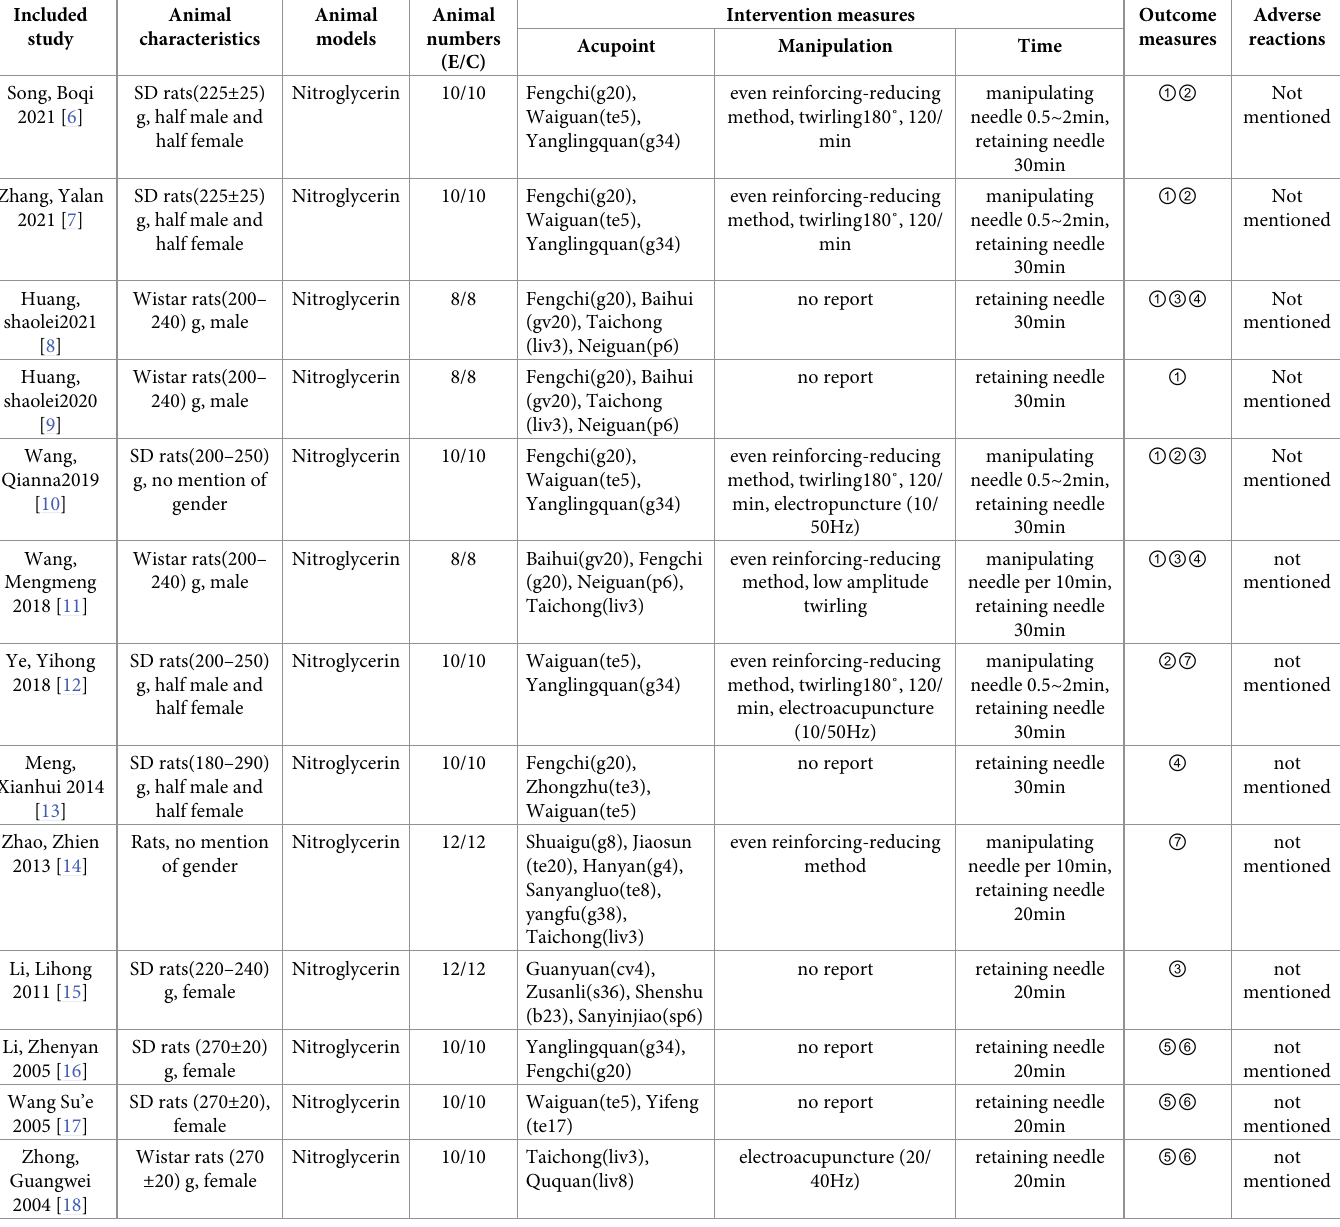
Table 1. Basic characteristics of included